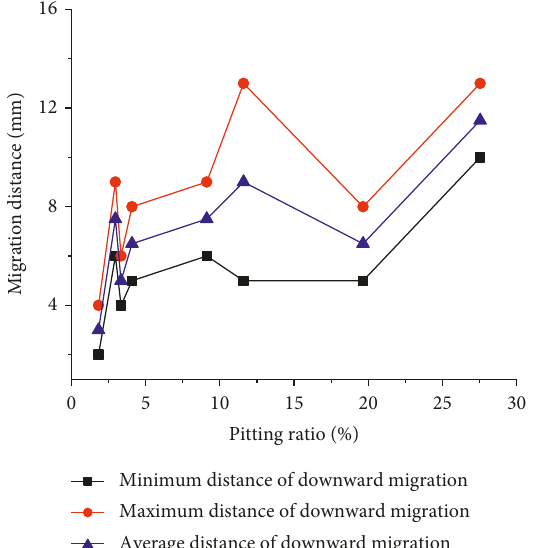
Figure 9: Diagram of downward migration pattern.